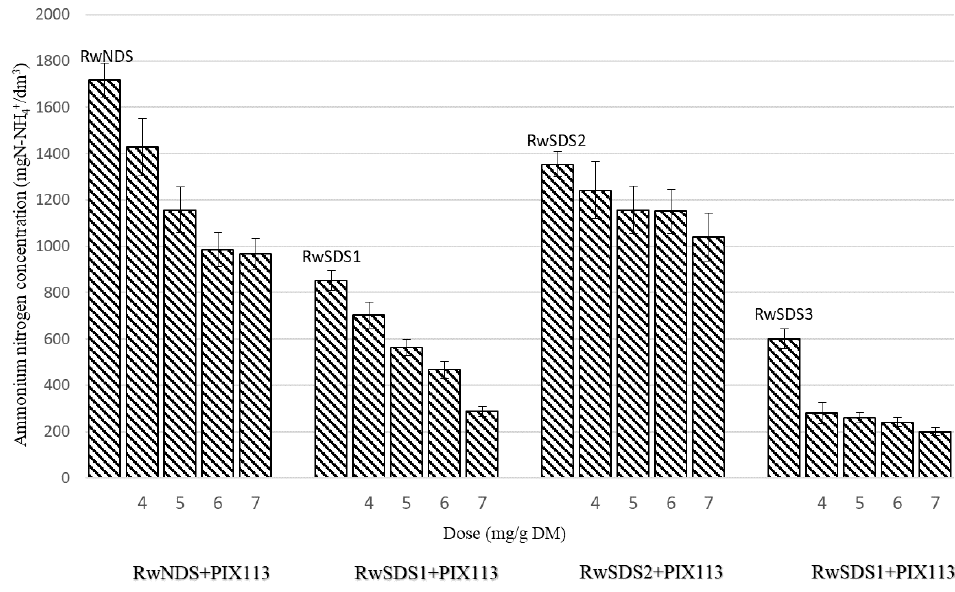
Figure 6. Changes of the ammonium nitrogen concentration in reject water separated from sludge prepared with PIX 113.